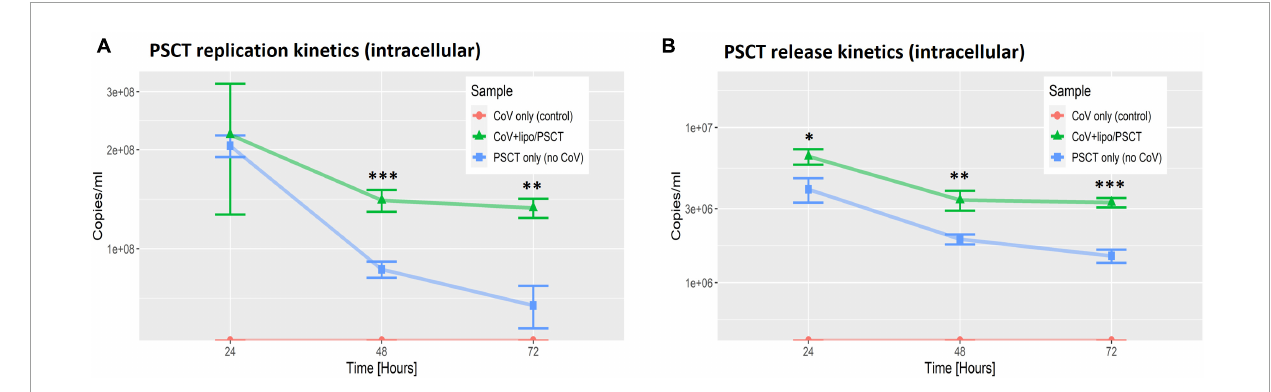
FIGURE4 PSCT mRNA replication and release levels are dependent on co-infection with SARS-CoV-2. Vero E6 cells were either uninfected (blue line) or infected (green line) with SARS-CoV-2 viral stock at low MOI, and subsequently transfected with liposome-encapsulated PSCT (250 ng/well). Additional control cell cultures were infected but left untreated (as specified in the label). The cell lysates (A) and supernatants (B) were collected at 24, 48, and 72 h p.i., and used to determine PSCT-mRNA levels (copies/ml) by multiplex qPCR, as detailed in the methods section. The graphs demonstrate that SARS-CoV-2-infected cells treated with liposome-encapsulated PSCT displayed significantly higher intracellular replication (A) and extracellular release (B) of PSCT mRNA, as compared to the uninfected cultures at all time points ( p < 0.01, for both analyses, by LME model). Data show the mean ± SEM of one representative experiment out of three performed in triplicates. Statistical analysis was performed by the LME model ( ∗ p < 0.05, ∗∗ p < 0.01, ∗∗∗ p <